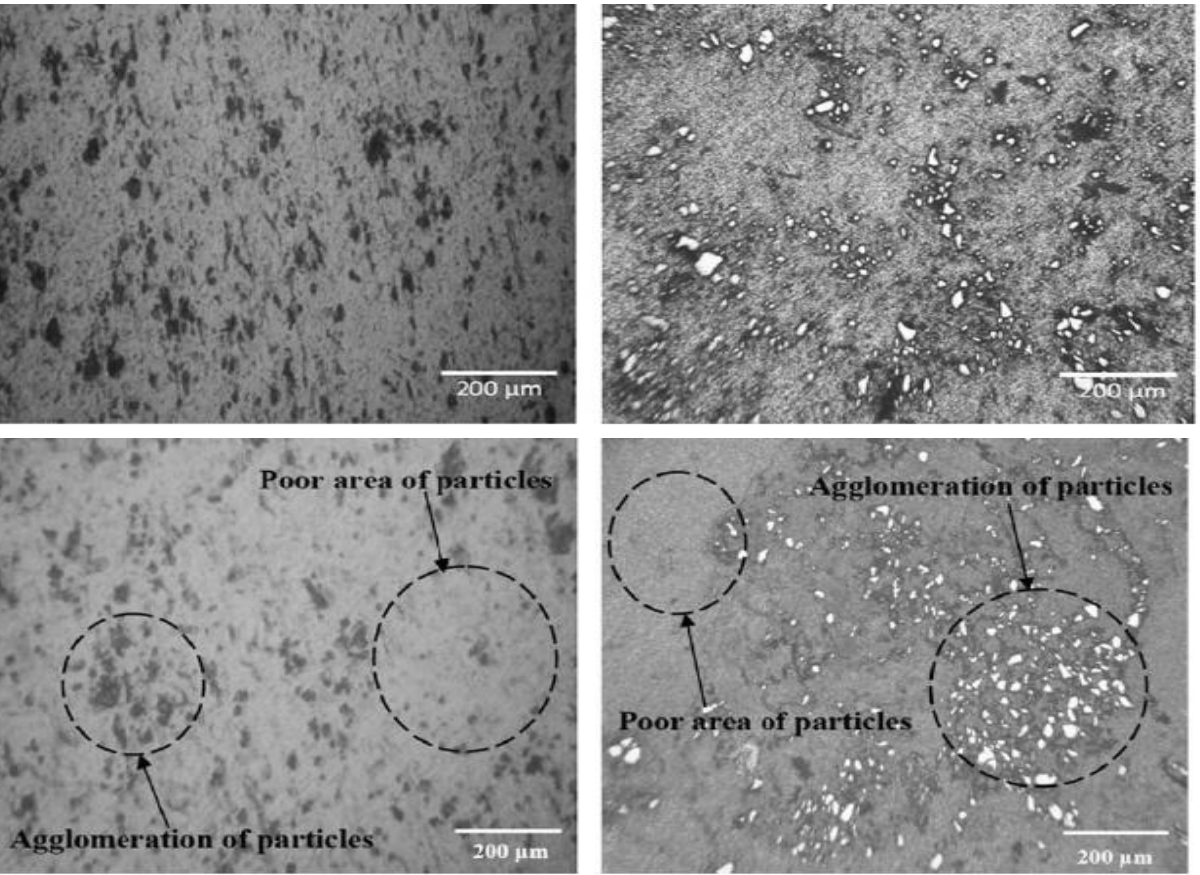
Figure 3. The micrographs of Al – TiC – B 4 C composite.